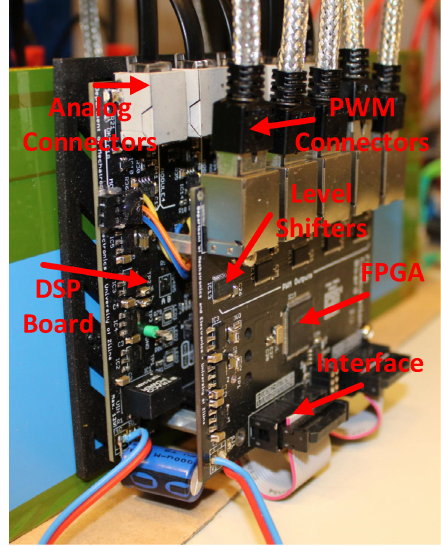
Figure 9. Control boards (DSP and